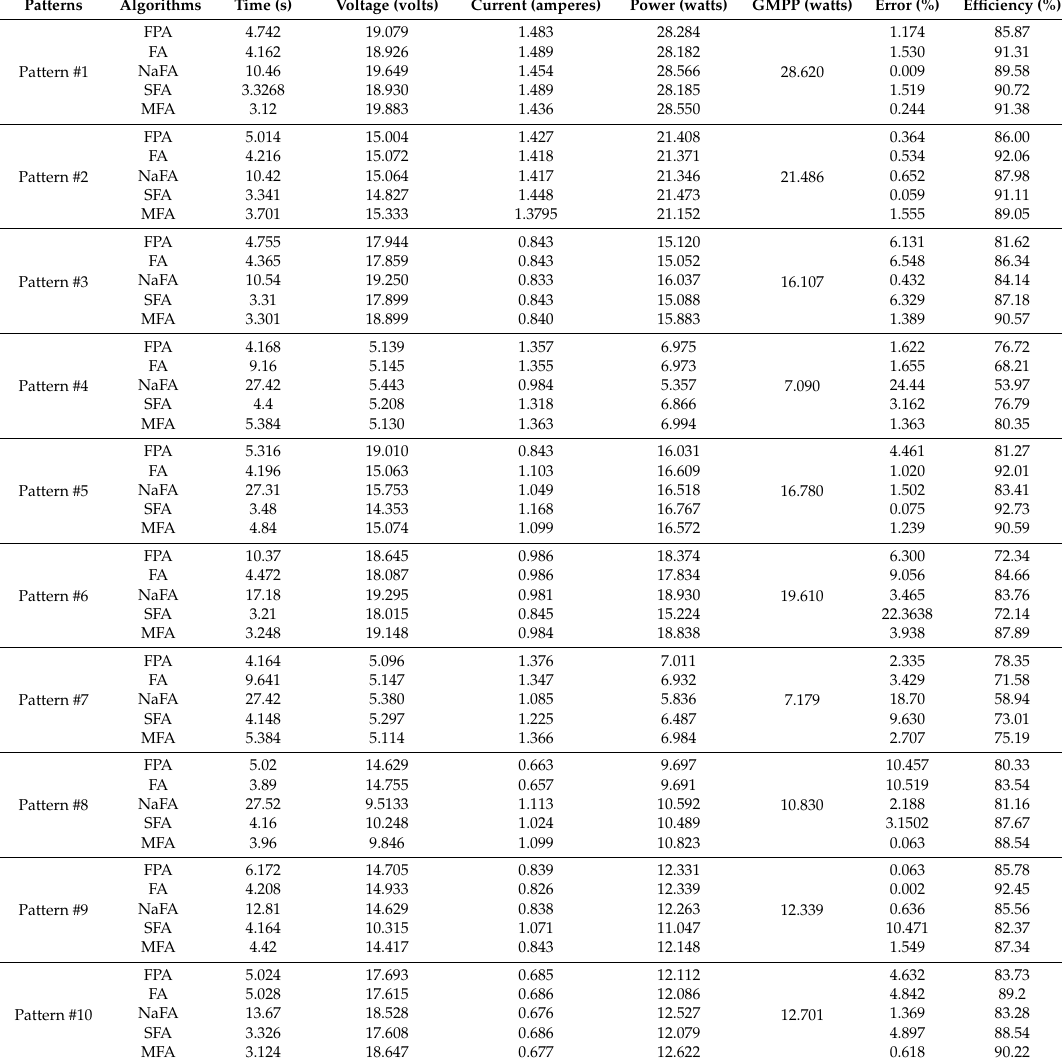
Table 14. Evaluation results of the tracking speed, accuracy and